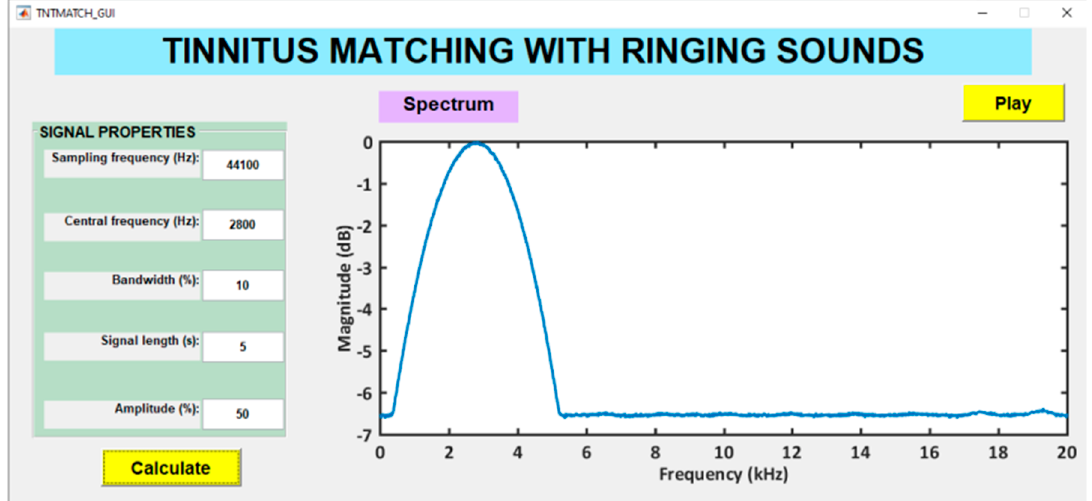
Figure 5. Custom-designed GUI for tinnitus pitch matching.